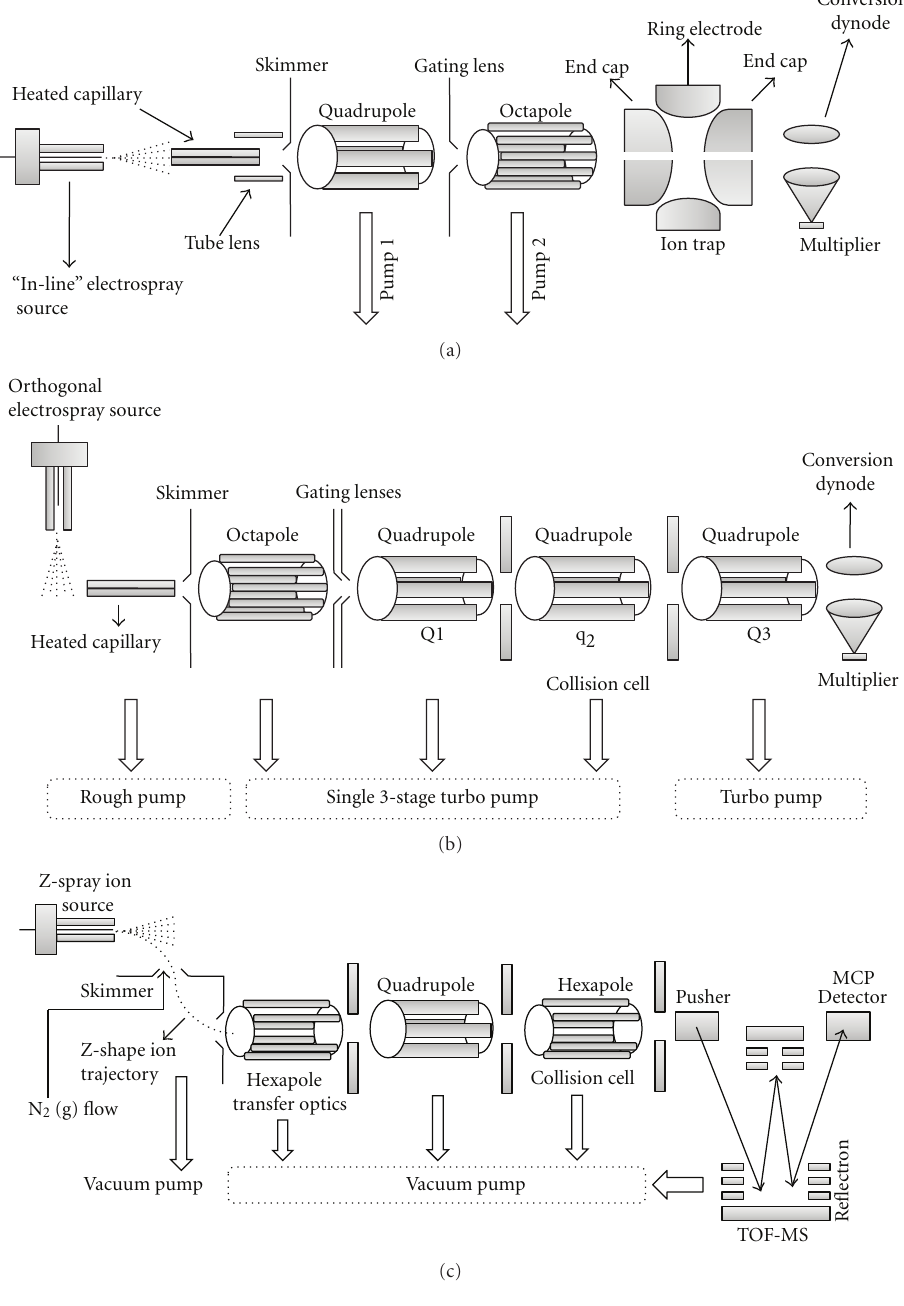
Figure 4: Schematic of the (a) thermo-Finnigan LCQ Deca mass spectrometer (on-axis spray), (b) Agilent 6410 Triple Quad LC/MS system (o ff -axis/orthogonal spray), and (c) Waters Micromass Q-TOF Ultima ESI-MS